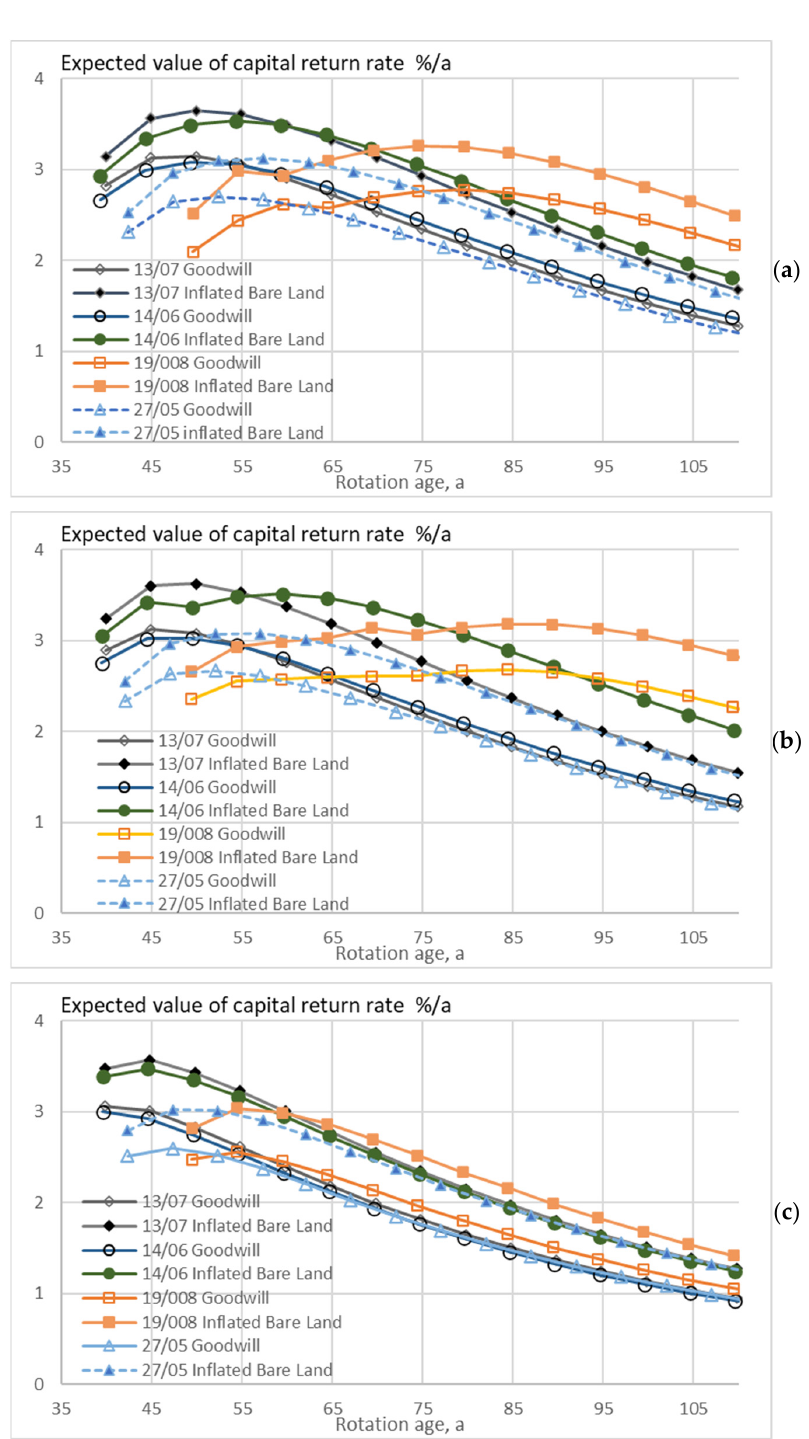
Figure 1. The expected value of capital return rate, as a function of rotation age, when the growth model is applied to four observed wooded stands, without any thinning restriction ( a ), good-quality trees of at least 238 mm of diameter only removed in thinning ( b ), and without any commercial thinning ( c ). Inflated capitalization is introduced either as proportional goodwill or as inflated bare land value; the numbers in legends identify stands and observation plots.